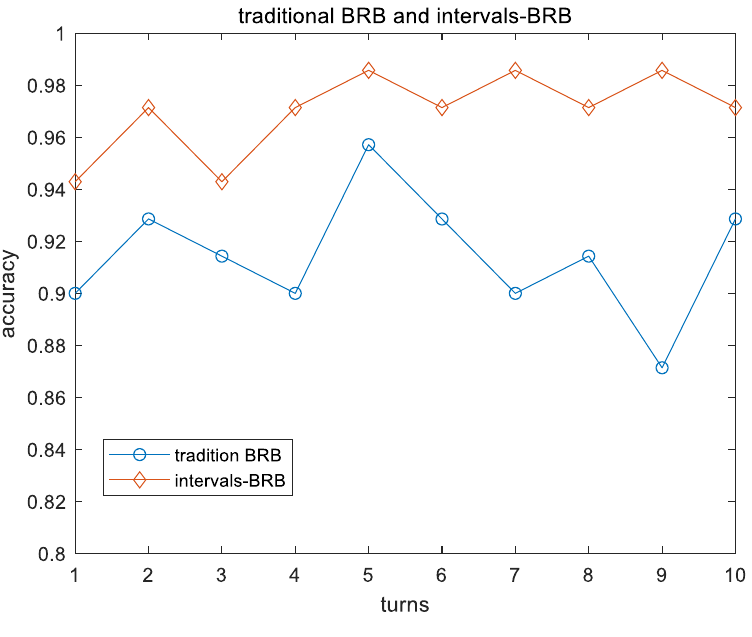
Figure 7. Ten rounds of trials.